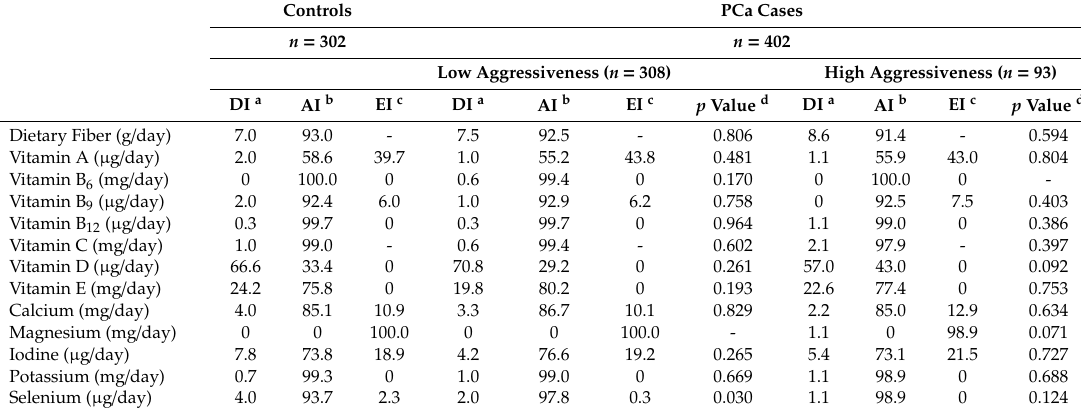
Table 5. Prevalence of participants with an adequate, deficient, or excessive intake of nutrients according to 2 / 3 European Food Safety Agency (EFSA) Dietary Reference Intakes (DRIs) in the control and cases group stratified by the aggressiveness of the prostate cancer.